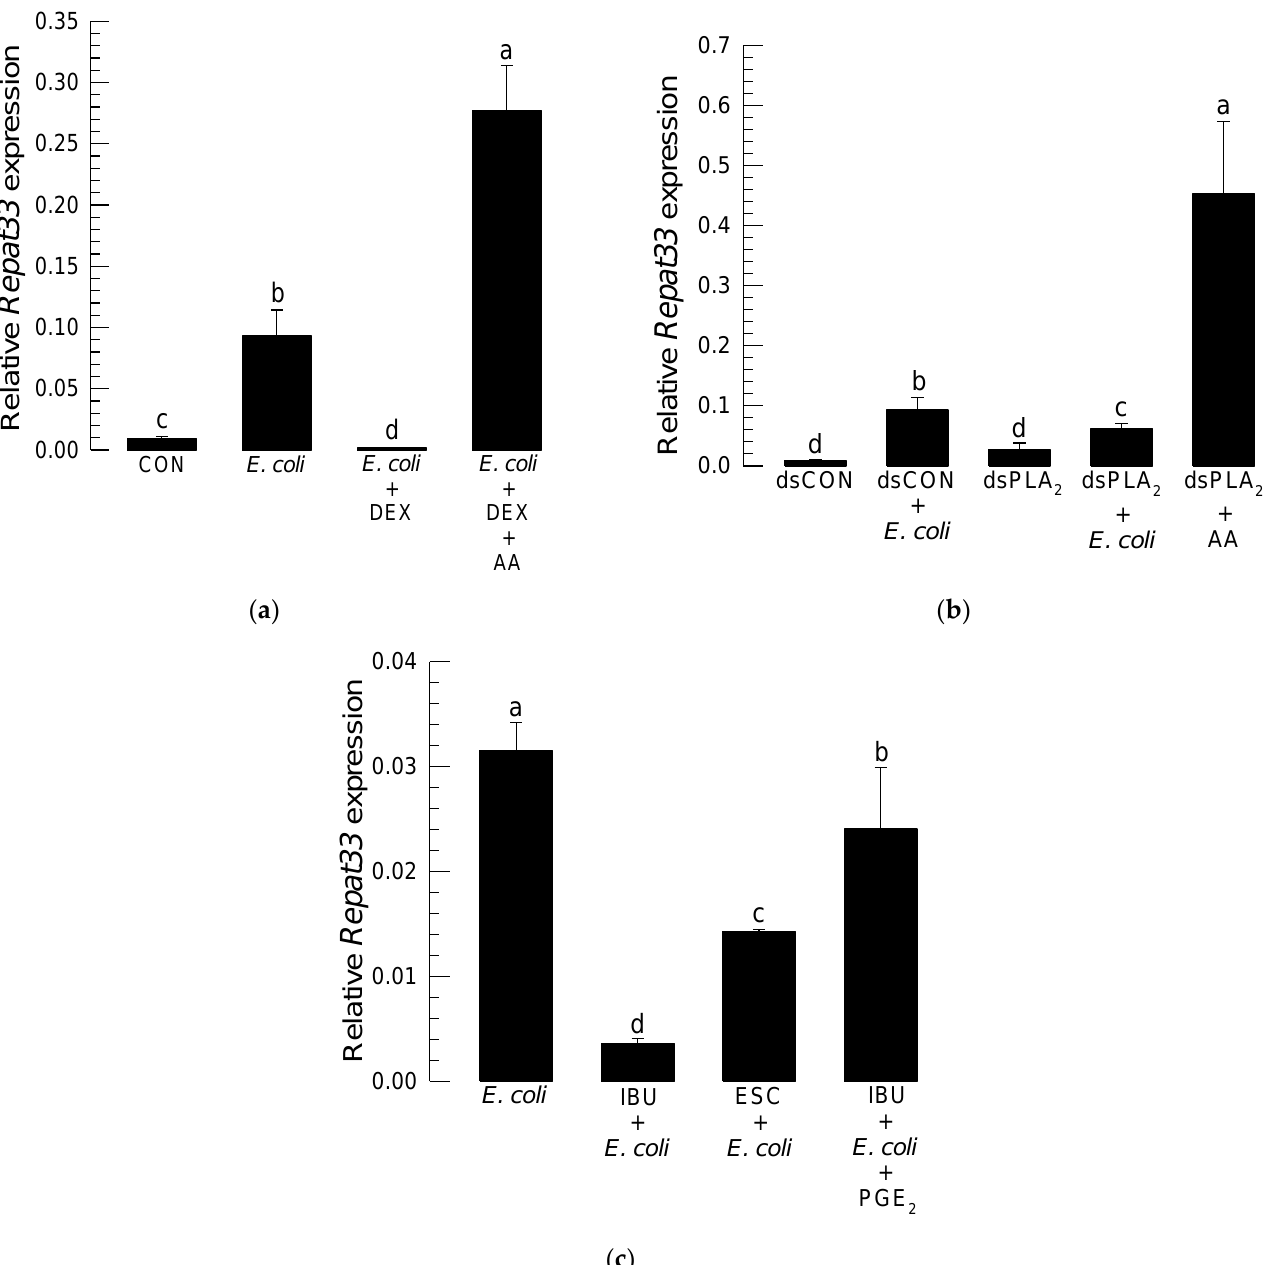
Figure 5. Influence of eicosanoids on Repat33 expression in L5 larvae of S. exigua . For the immune challenge, E. coli (10 4 cells/larva) was injected into L5 larvae followed by incubation at 25 °C for 8 h. ( a ) Inhibitory effect of dexamethasone (‘DEX’, a specific PLA 2 inhibitor, 1 µg/larva) on Repat33 expression. The addition of arachidonic acid (AA, a catalytic product of PLA 2 , 1 µg/larva) rescued Repat33 expression suppressed by DEX. ( b ) Inhibitory effect of RNA interference (RNAi) of a PLA 2 gene (= Se-sPLA 2 ) of S. exigua on Repat33 expression. RNAi was performed by injecting 1 µg of dsRNA (‘dsPLA2′ ) specific to Se-sPLA 2 to each larva. A GFP gene was used to construct a control dsRNA (‘dsCON’). At 24 h after dsRNA injection, larvae were subjected to immune challenge. At 8 h after injection, total RNA was isolated from the fat body for RT-qPCR analysis of Repat33 expression. ( c ) Effect of ibuprofen (‘IBU’, a COX inhibitor, 1 μg/larva) or esculetin (‘ESC’, a LOX inhibitor, 1 μg/larva) on Repat33 expression. The addition of PGE 2 (a catalytic product of COX, 1 µg/larva) rescued Repat33 expression suppressed by IBU or ESC. A ribosomal protein gene, RL32 , was used as a reference gene for RT-qPCR. Each treatment was replicated three times with independent biological sample preparations. Different letters indicate significant differences among means at Type I error = 0.05 (LSD test).